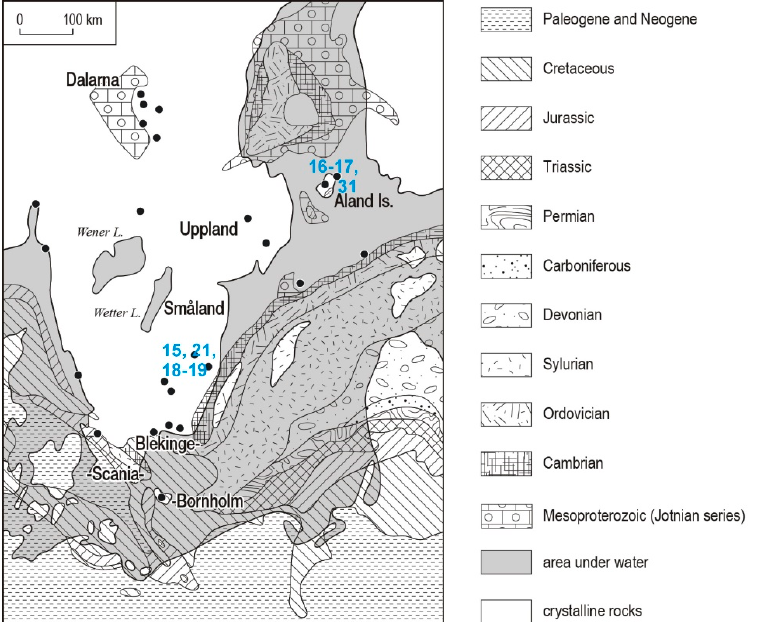
Figure 3. Outcrops of parent rocks (cyphers in blue) for erratics collected in the IGES Rock Garden